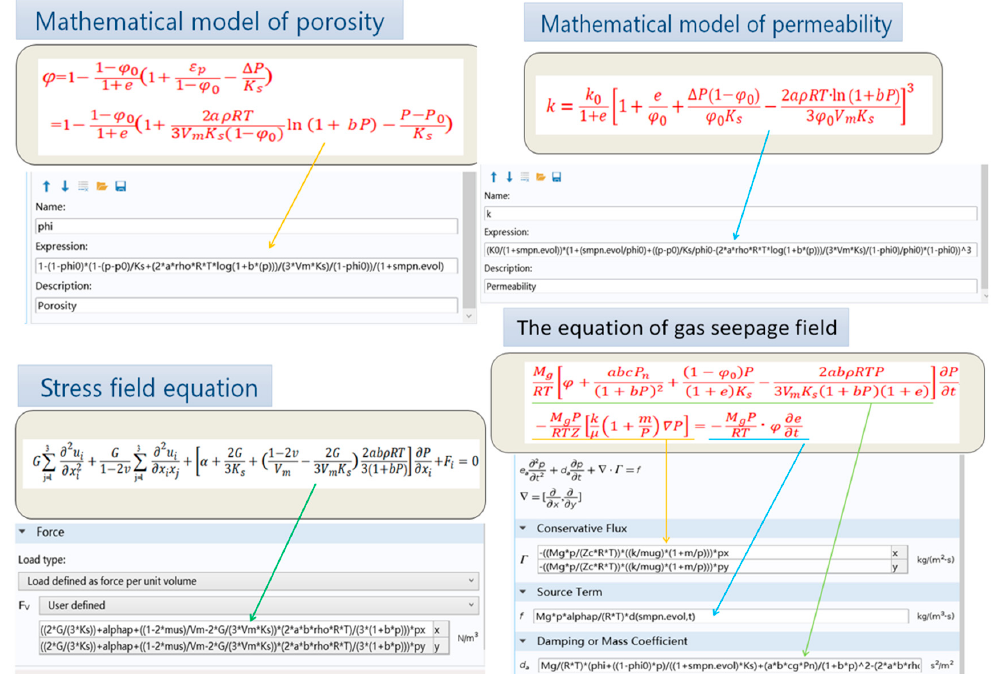
Figure 4. Mathematical model input.